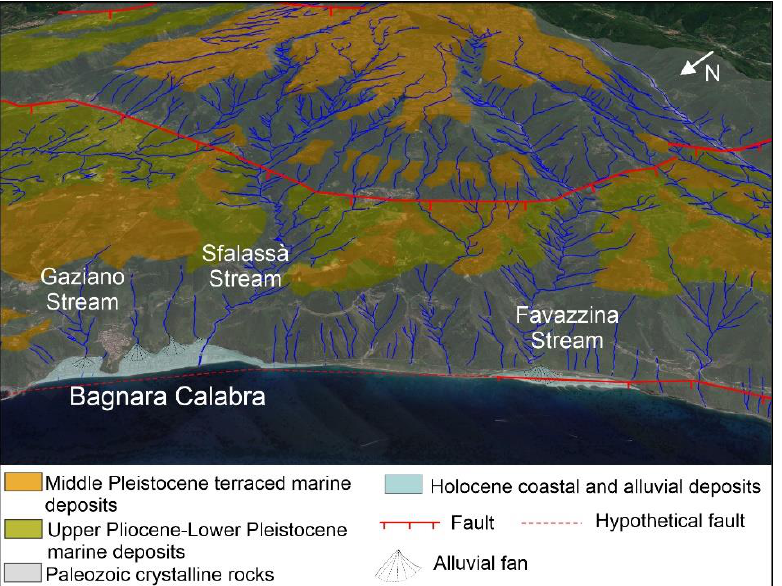
Figure 2. Schematic map of geological features of Bagnara Calabra and surrounding areas. Source: own elaboration on the basis of previous studies cited in this paragraph and overlaid to Google Earth images.